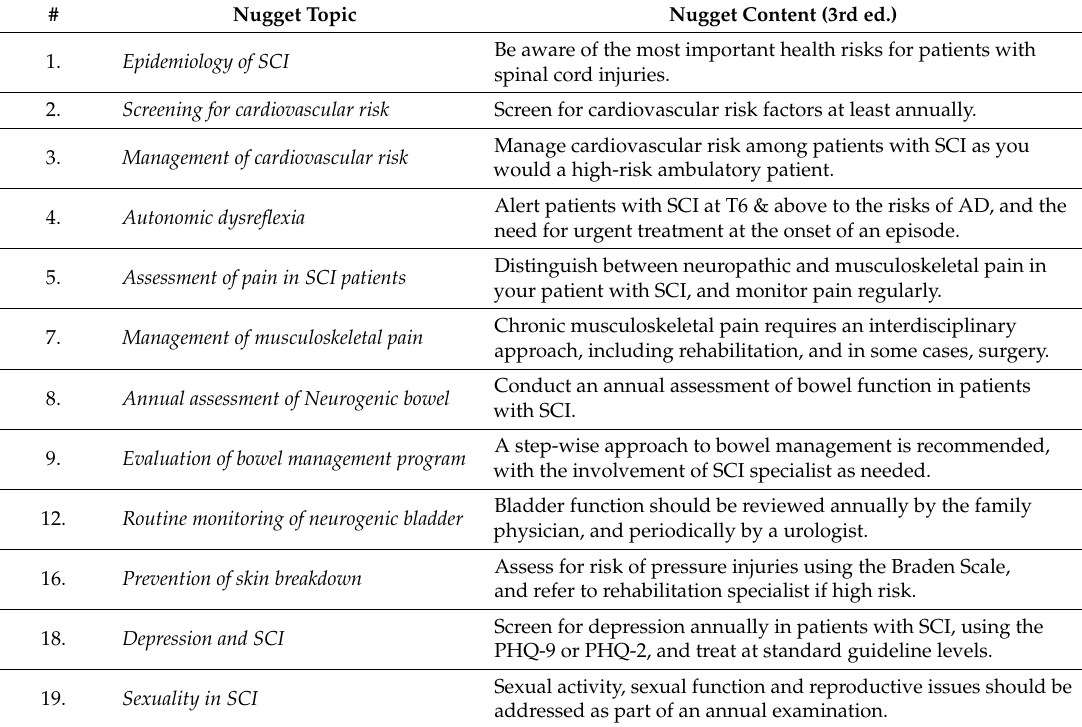
Table 2. 12 Nuggets with minor